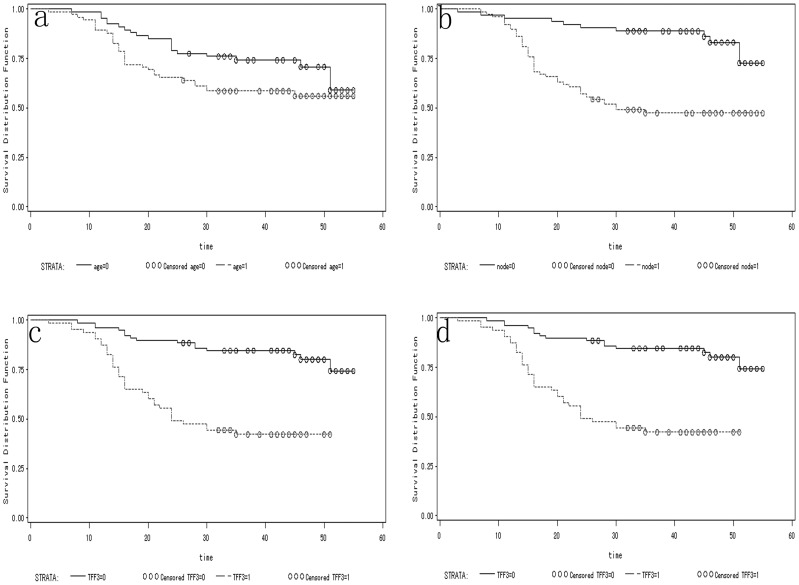
Kaplan-Meier overall survival curves of 142 GC patients according to age (a), lymph node metastasis (b), TFF3 expression (c), and TACC1 expression (d) (P<0.05).Abbreviations: age = 0 means age≤60 years; age = 1 means age>60 years. node = 0 means no lymph node metastasis; node = 1 means lymph node metastasis.